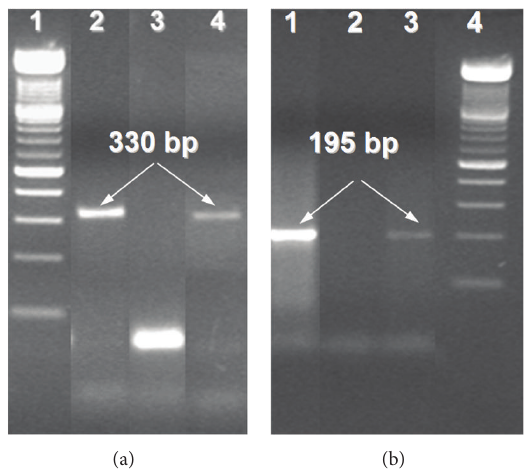
Figure 5: Molecular detection of T. cruzi by PCR. (a) Amplification of the variable region of kDNA minicircles from trypanosomes (amplicon: 330 bp); line 1: 100bp DNA ladder as molecular marker; line 2: positive control of DNA from human blood infected with T. cruzi ;line3:distilledwaterasnegativecontrol;andline4:DNAfrom PF- and PE-sections of the frontal lobe SOL. (b) Amplification of a repeated sequence from T. cruzi satellite DNA (amplicon: 195 bp); line 1: positive control of DNA from human blood infected with T. cruzi ; line 2: distilled water; line 3: DNA from PF- and PE-sections of the frontal lobe SOL; and line 4: 100 bp DNA ladder as molecular